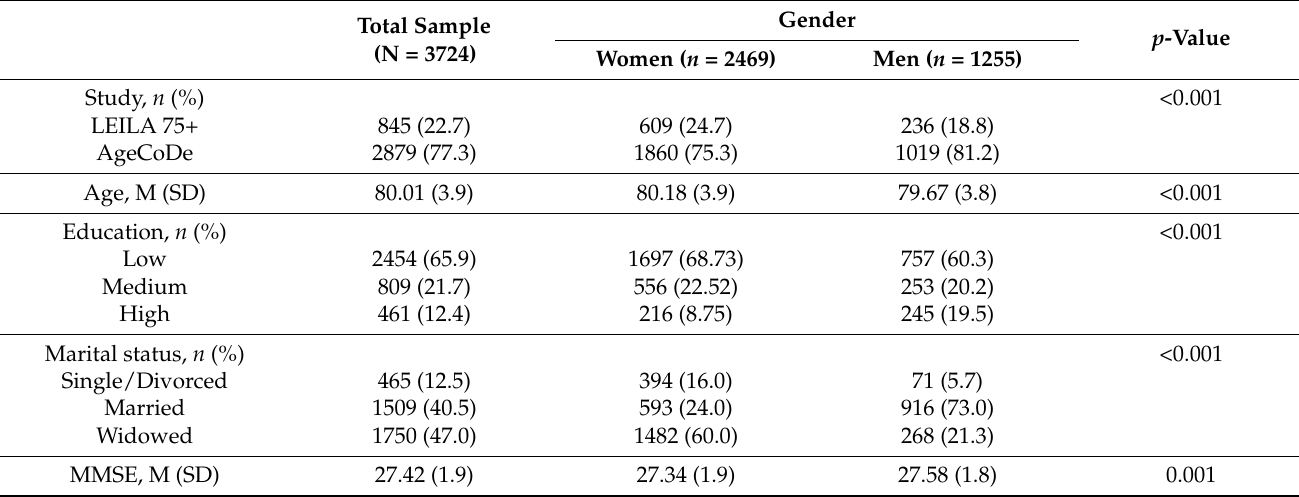
Table 1. Sociodemographic characteristics at baseline for the total sample and by